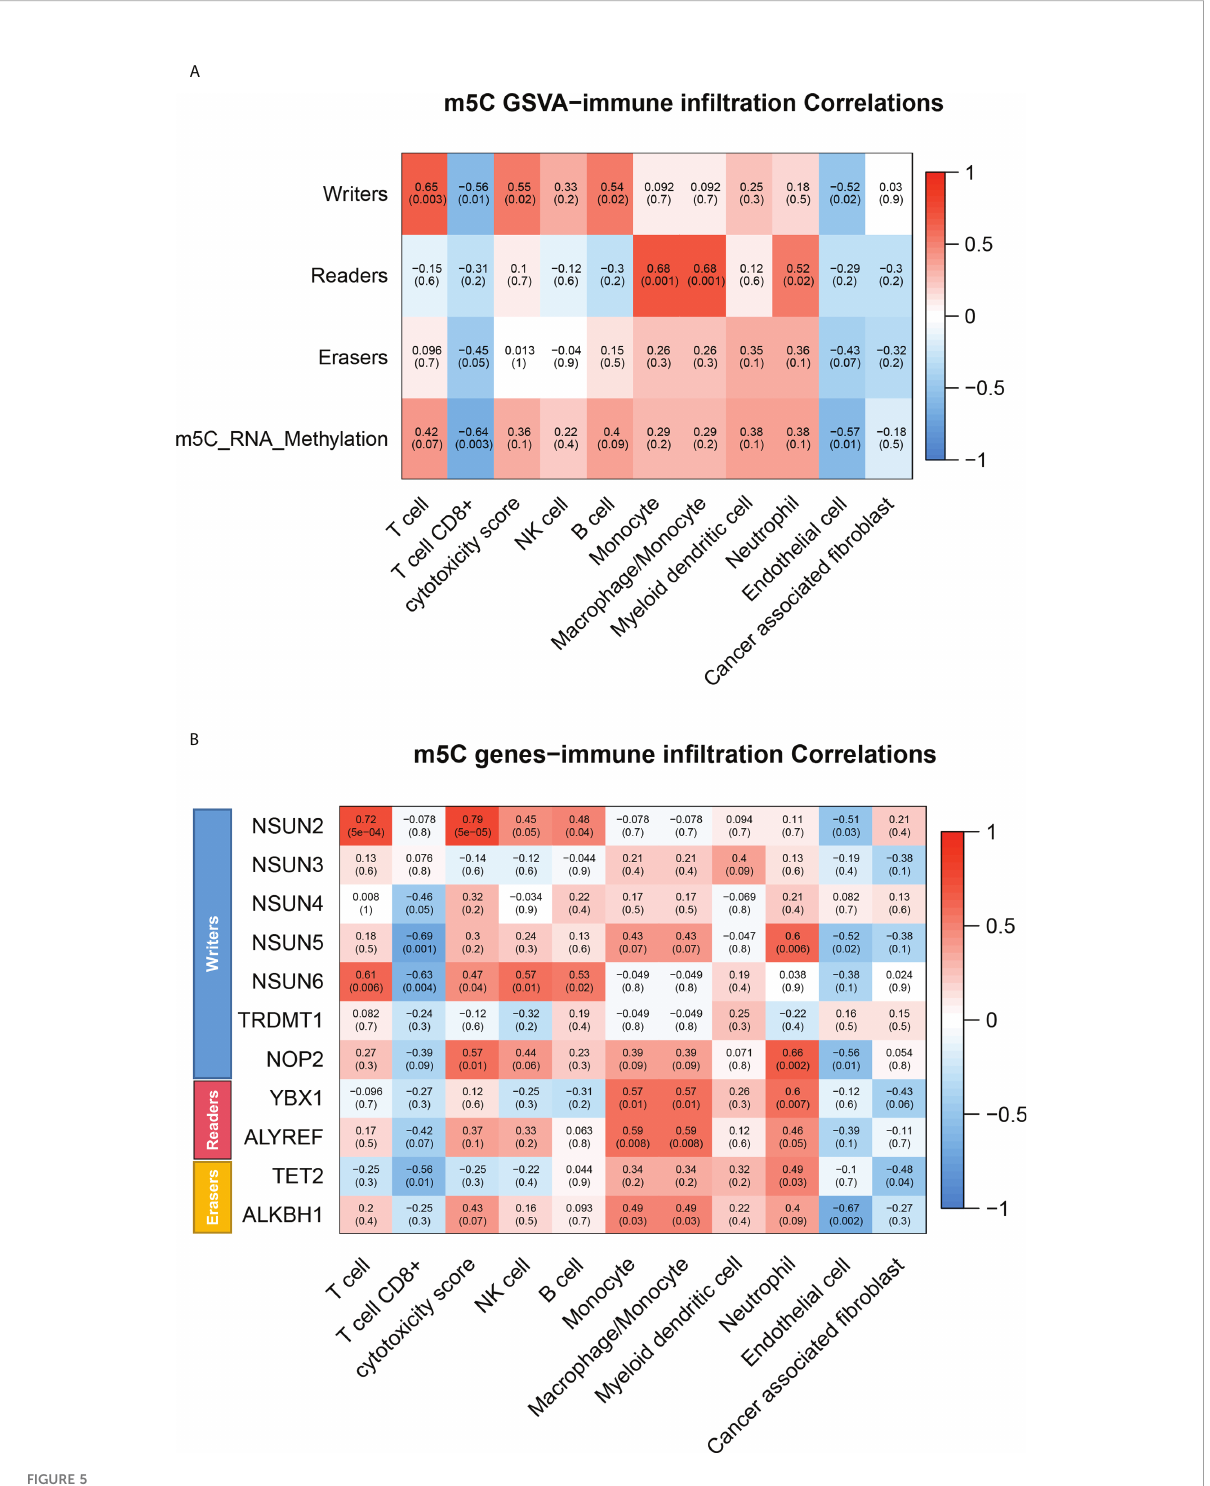
FIGURE 5 m 5 C modi fi cation of various immune cells in peripheral blood of CRC patients. (A) Heatmap of correlation between in fi ltrating immune cell types and m 5 C modi fi cation pathways in blood of CRC patients by GSVA. (B) Heatmap of correlation between in fi ltrating immune cell types and m 5 C modi fi cation related gene in blood of CRC patients by GSVA. NS, no signi fi